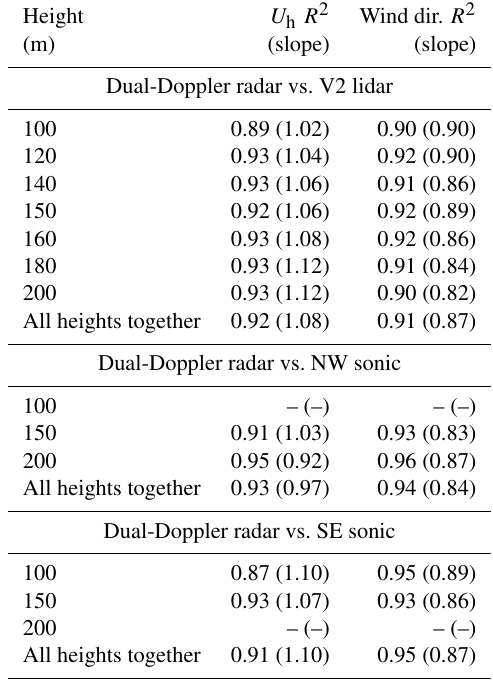
Table 5. Linear regression analysis of Ka-band radars against sonic anemometer and V2 lidar